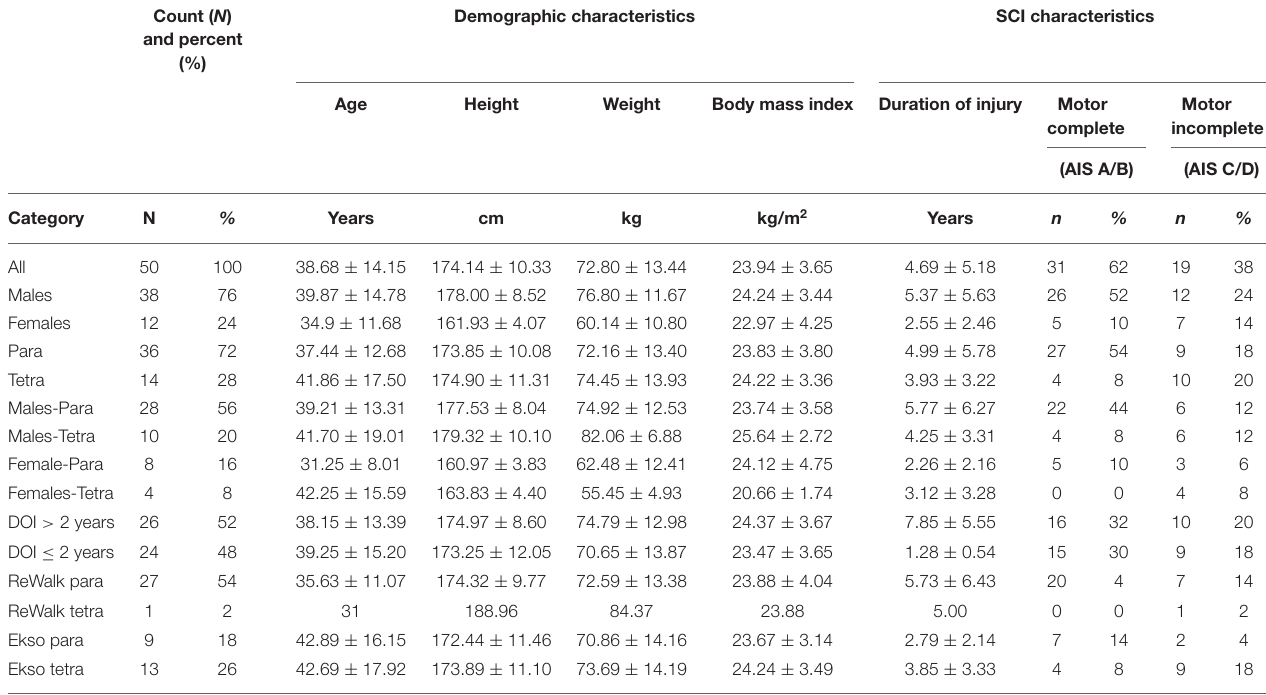
TABLE 3 | Demographic and spinal cord injury characteristics of the total study group. Count ( N ) and percent